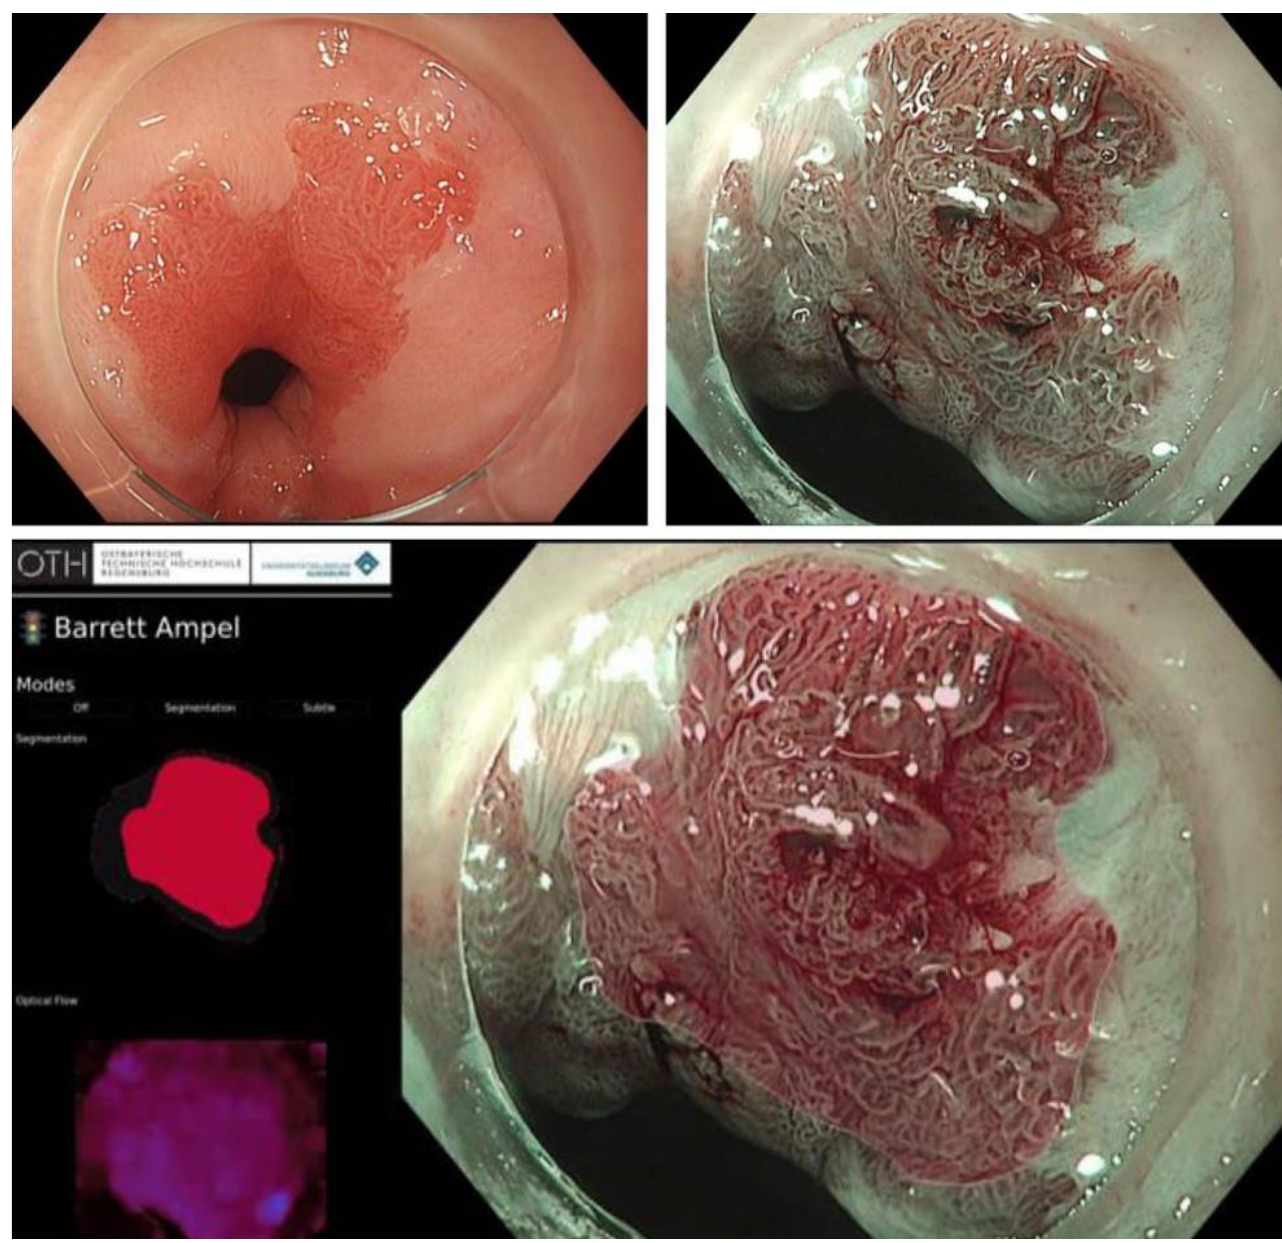
Figure 2. Example of a small Barrett’s-associated adenocarcinoma detected by the Augsburg artificial intelligence system [21]. Top right : close-up view (HD-WLE). Top left : close-up view (NBI mode). Bottom : functionality of the ‘Barrett traffic light’, which gives a heat map indicating areas suspicious of dysplasia in red — corresponding to the endoscopic image on the right side of the picture.